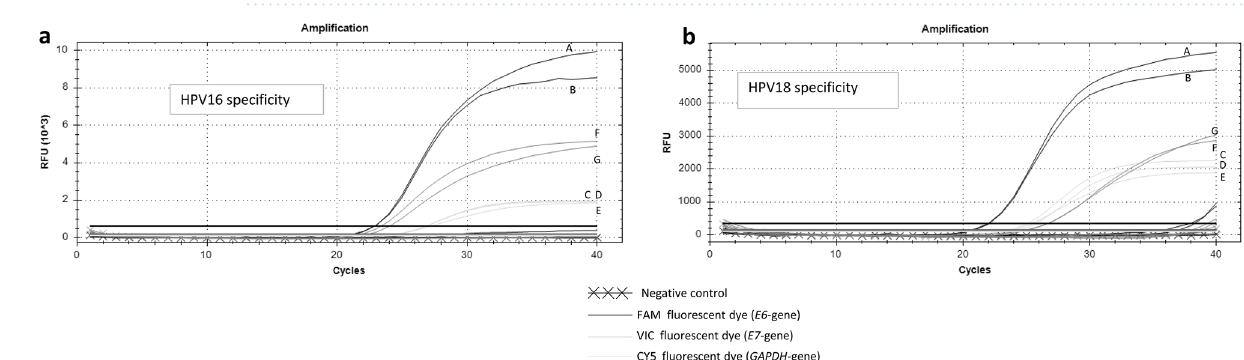
Figure 1. Amplification patterns obtained with the multiplex systems on plasmid DNA. The curves were generated by amplification of 10 5 copies of plasmid/2µL of single or pooled E6 , E7 and/or GAPDH plasmid for HPV16 and HPV18. ( a ) Specificity of HPV16 E6 , E7 and GAPDH multiplex for the detection of HPV16 plasmid pool (A, E, G), HPV16 E6 plasmid (B), GAPDH plasmid (C), HPV16 E7 plasmid (F) and HPV18 plasmid pool (D) ( b ) Specificity of HPV18 E6 , E7 and GAPDH multiplex for the detection of HPV18 plasmid pool (B, E, G), HPV18 E6 plasmid (A), GAPDH plasmid (C), HPV18 E7 plasmid (F), HPV16 plasmid pool